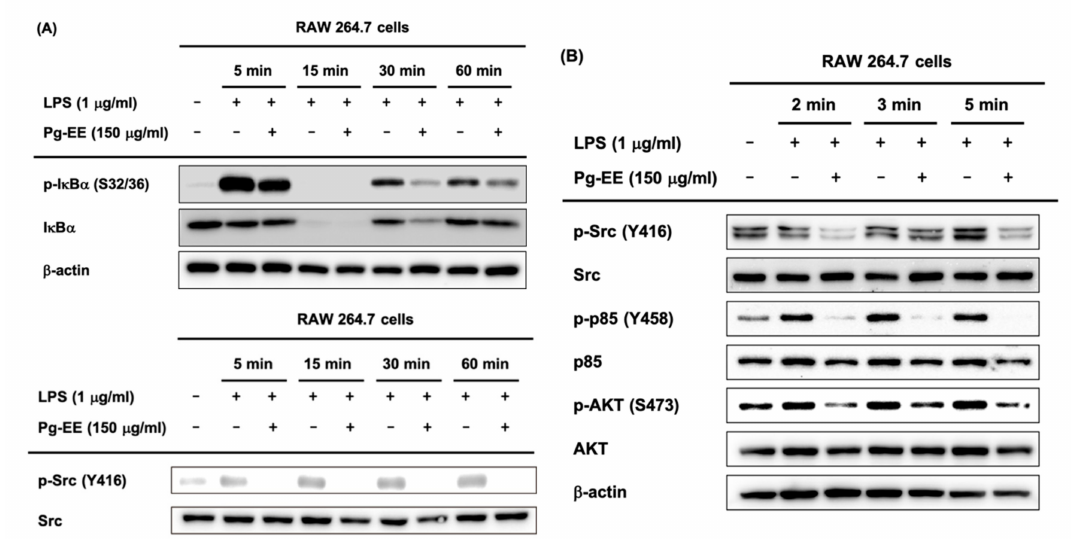
Figure3. E ff ectofPg-EEontheactivationofsignalingmoleculesintheNF- κ Bpathway. ( A , B )Employing western blot analysis, the total and phosphorylated protein levels of inhibitor of kappa B alpha (I κ B α ), AKT, p85, Src, and β -actin were determined using whole cell lysates from LPS (1 µ g / mL)-stimulated RAW264.7 cells with or without Pg-EE (150 µ g / mL) in a time-dependent manner. − : no treatment and + :